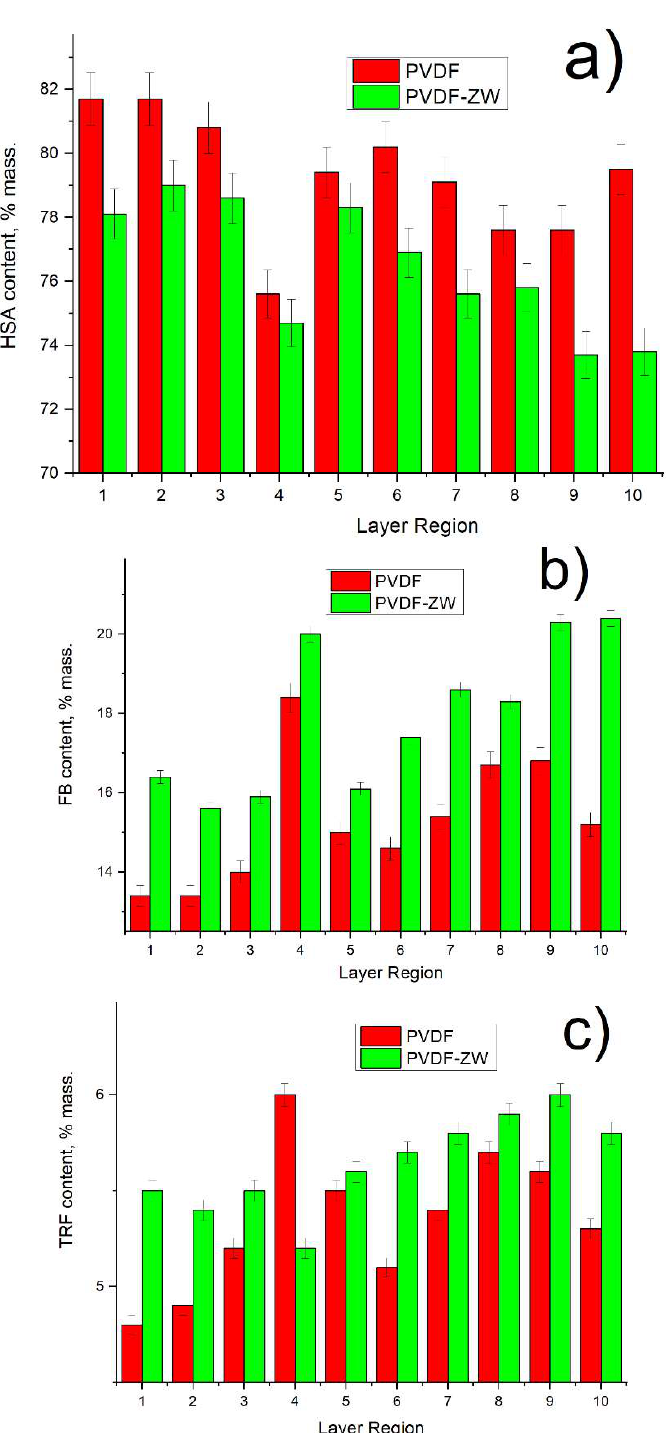
Figure 6. Protein content in adsorbed protein mixture depending on membrane region index: ( a ) HSA; ( b ) FB; ( c ) TRF.